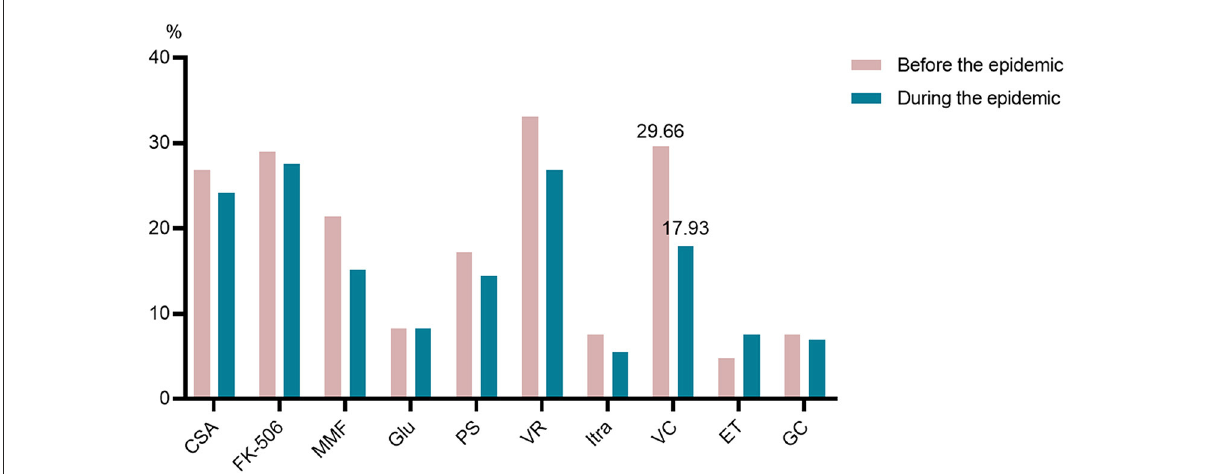
FIGURE3 Routine medicines after hematopoietic stem-cell transplantation. CSA, cyclosporine a; FK-506, tacrolimus; MMF, mycophenolate mofetil; GLU, glucocorticoids; PS, posaconazole; VR, voriconazole; Itra, itraconazole; GC, garlicin capsules; VC, valaciclovir; ET, entecavir.